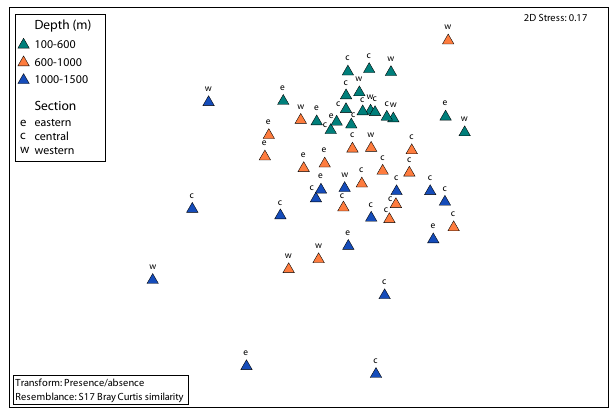
Transform: Presence/absence Resemblance: S17 Bray Curtis similarity Fig. 7 . Non-metric multidimensional scaling ordination based on Bray–Curtis similarity coefficients for presence/absence data for features subdivided by depth